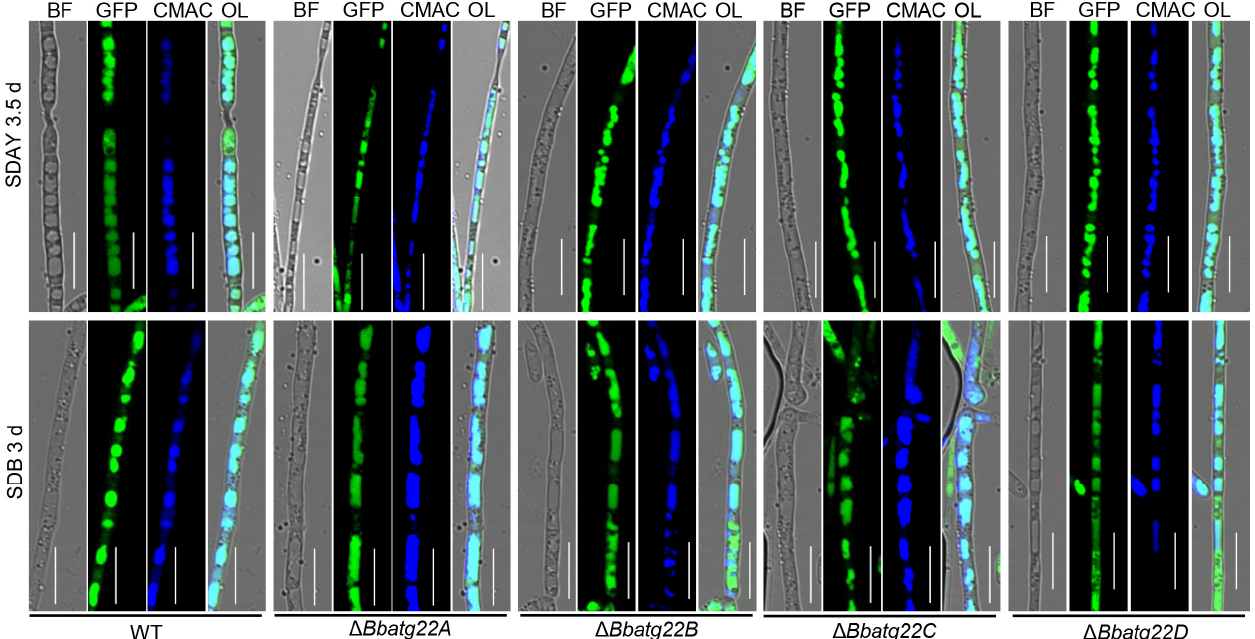
Figure 3. Autophagic flux during fungal development. A fusion gene of GFP-BbATG8 was integrated in the wild type and four disruptants to track the autophagic process in mycelia during development. Transformant were cultured on SDAY and in SDB for 3.5 d and 3 d, respectively. Vacuoles were indicated by staining with fluorochrome. Green signals overlapped with blue signals from CMAC. Scale bars: 5 µm.